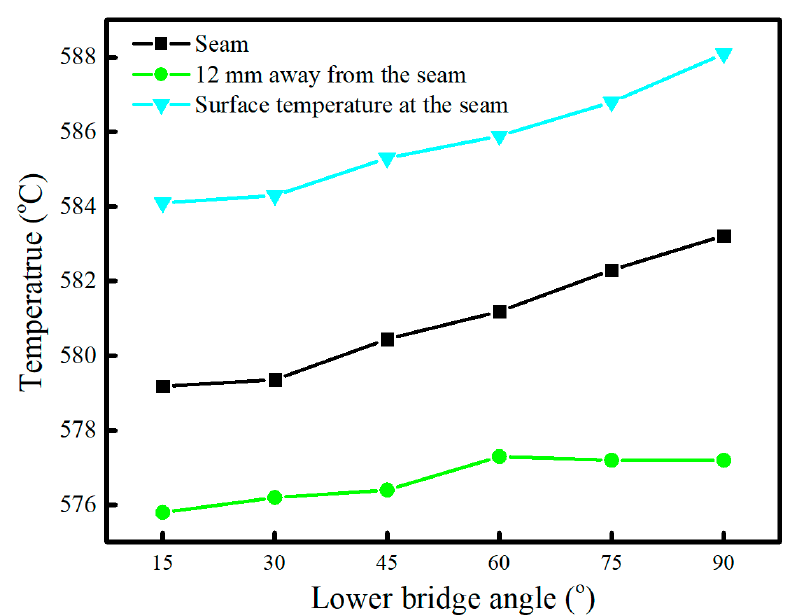
Figure 11. Effect of lower bridge angle on the model-predicted temperature of the extrudate at a mid-thickness location for the weld seam (black), 12 mm away from the weld seam (green) and the surface temperature above the weld seam (blue).